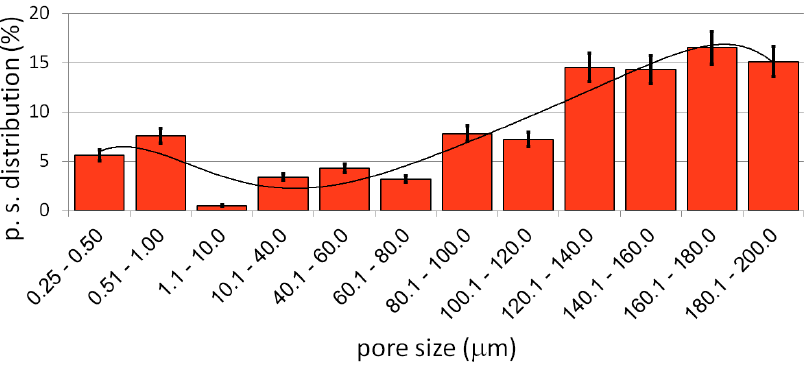
Figure 7. The pore size distribution of the Ti40Ta3Ag foam.